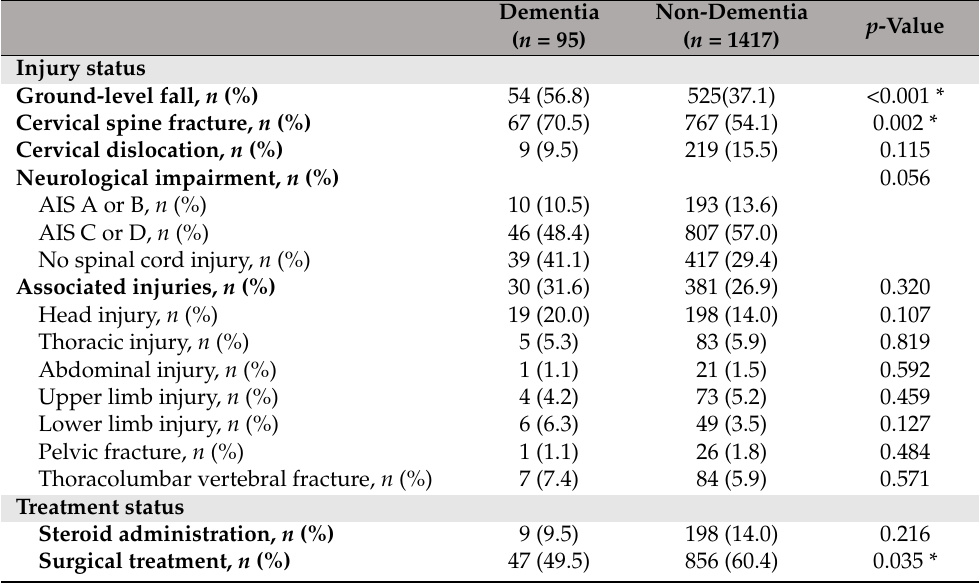
Table 2. Comparison of the injury and treatment status between the dementia and non- dementia groups.